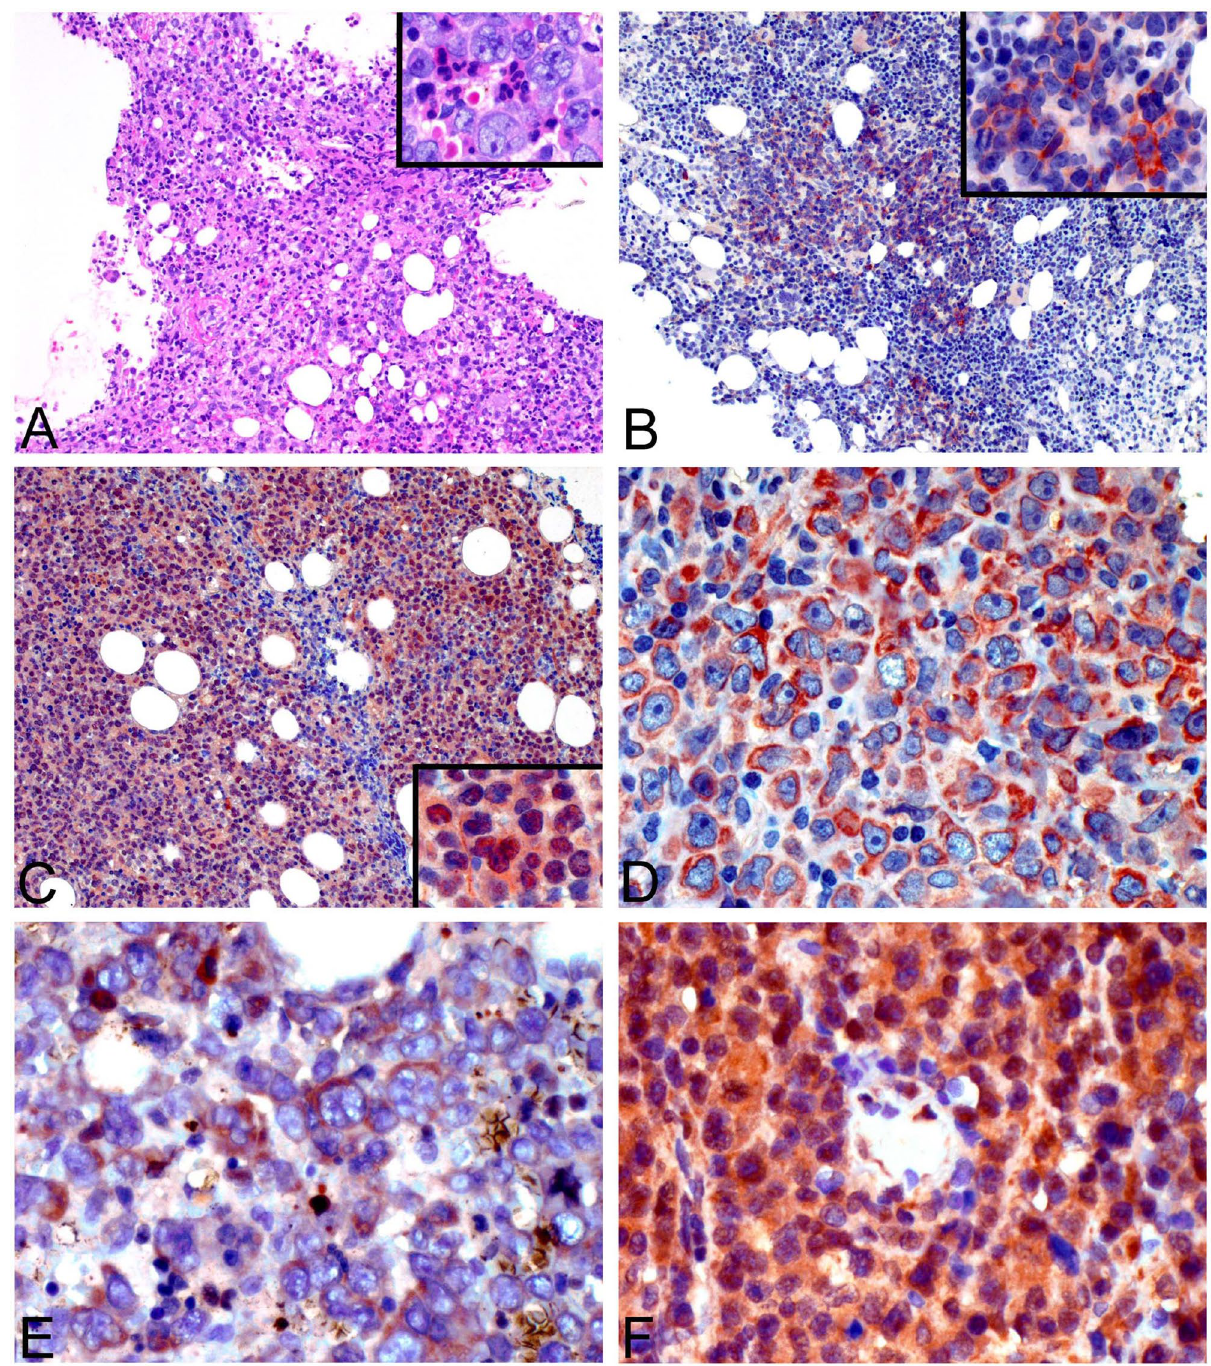
Figure 1. Pathologic findings of DLBCL with expression of five candidate genes. ( A ) BLS-type DLBCL shows patchy or interstitial infiltration by tumor cells in the bone marrow without sinusoidal involvement (HE stain, 100X). The centroblast-like tumor cells show large, vesicular nuclei with one to several prominent nucleoli (inset, 400X). ( B ) Immunohistochemical analysis showed that the lymphoma cells involving bone marrow express NANOG in the cytoplasm in contrast to the negative hematopoietic elements (100X; inset, 400X). ( C ) Lymphoma cells in this nodal case are positive for HOXA9 in nuclei (100X; inset, 400X). ( D ) S100A8 (MRP8) is positive in the cytoplasm of tumor cells of a nodal case (400X). ( E ) This case of BLS-type DLBCL involving bone marrow expresses cytoplasmic BMP8B (400X). ( F ) This nodal case expresses CCR6 in cytoplasm